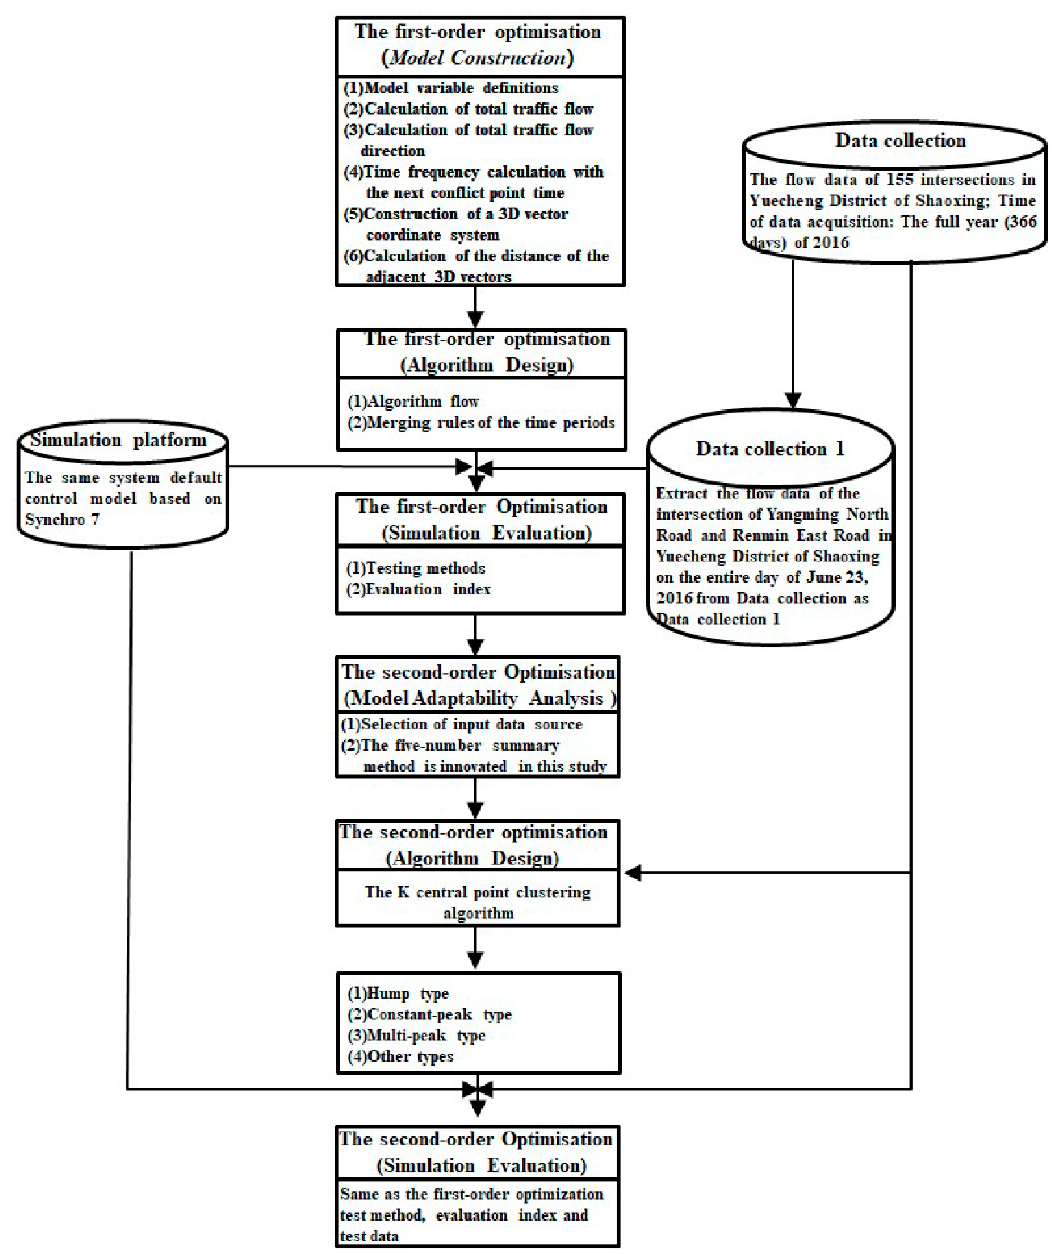
Figure 2. Procedural framework.